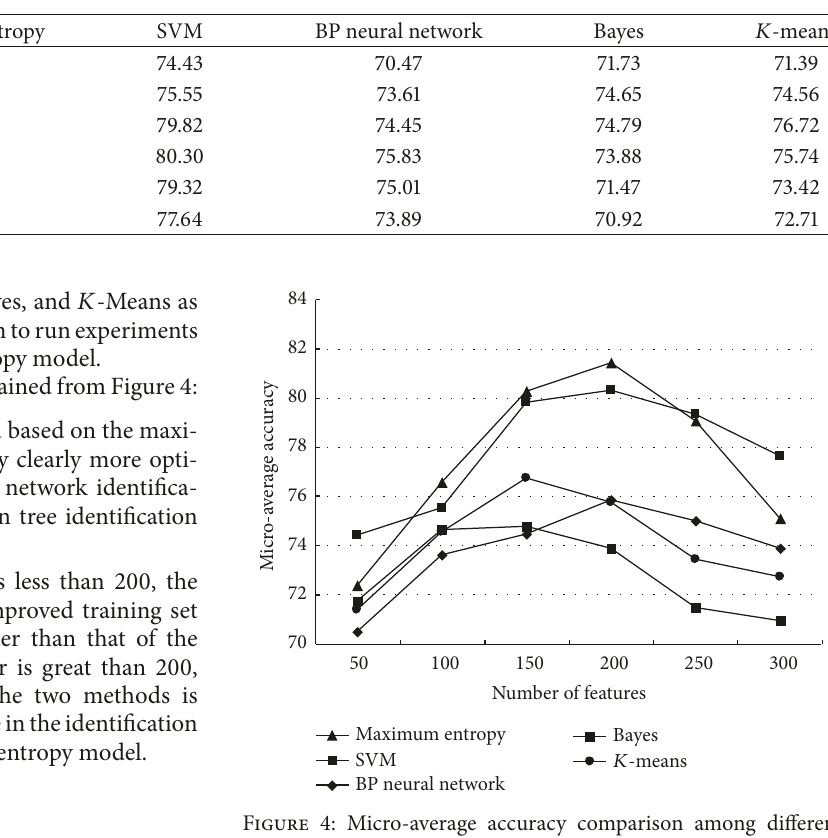
Table 3: Micro-average accuracy comparison among different classification approaches.